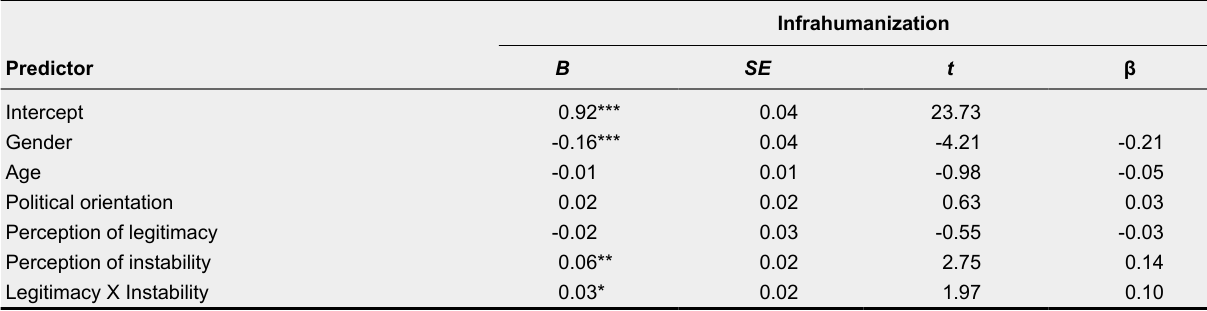
Infrahumanization B SE t β